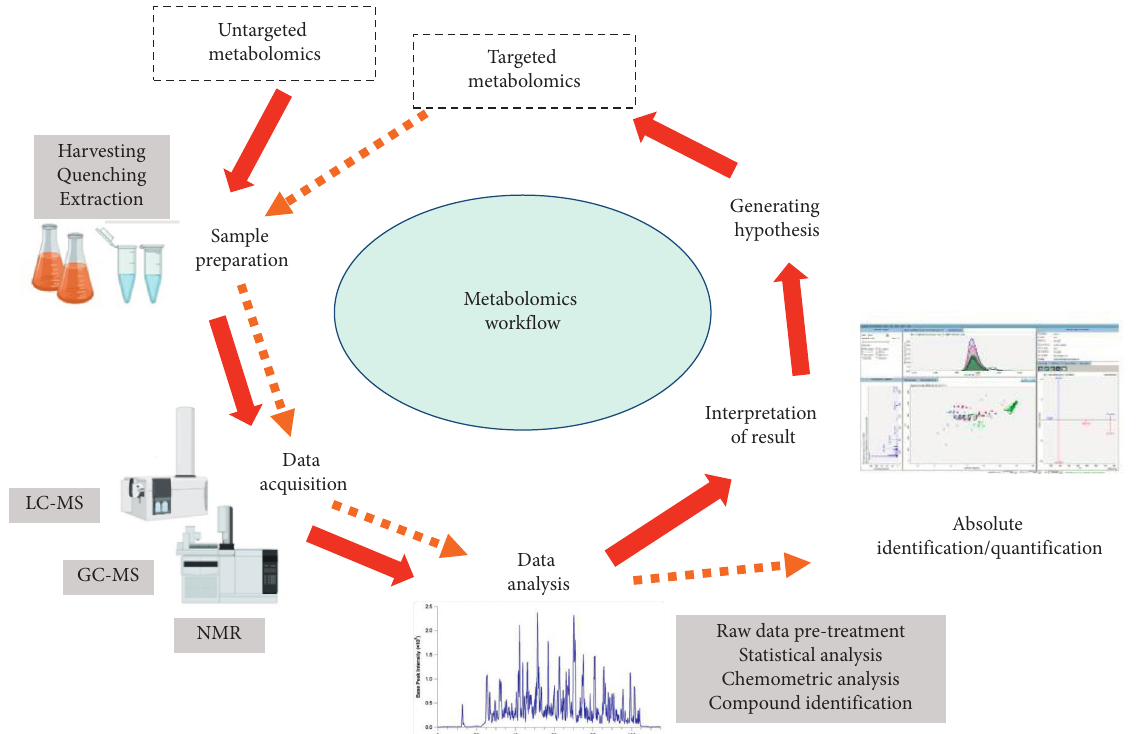
Figure 1: Overview of general metabolomics workflow. Solid (red) arrow represents the flow of untargeted metabolomics, while dotted (orange) arrow represents the flow of targeted